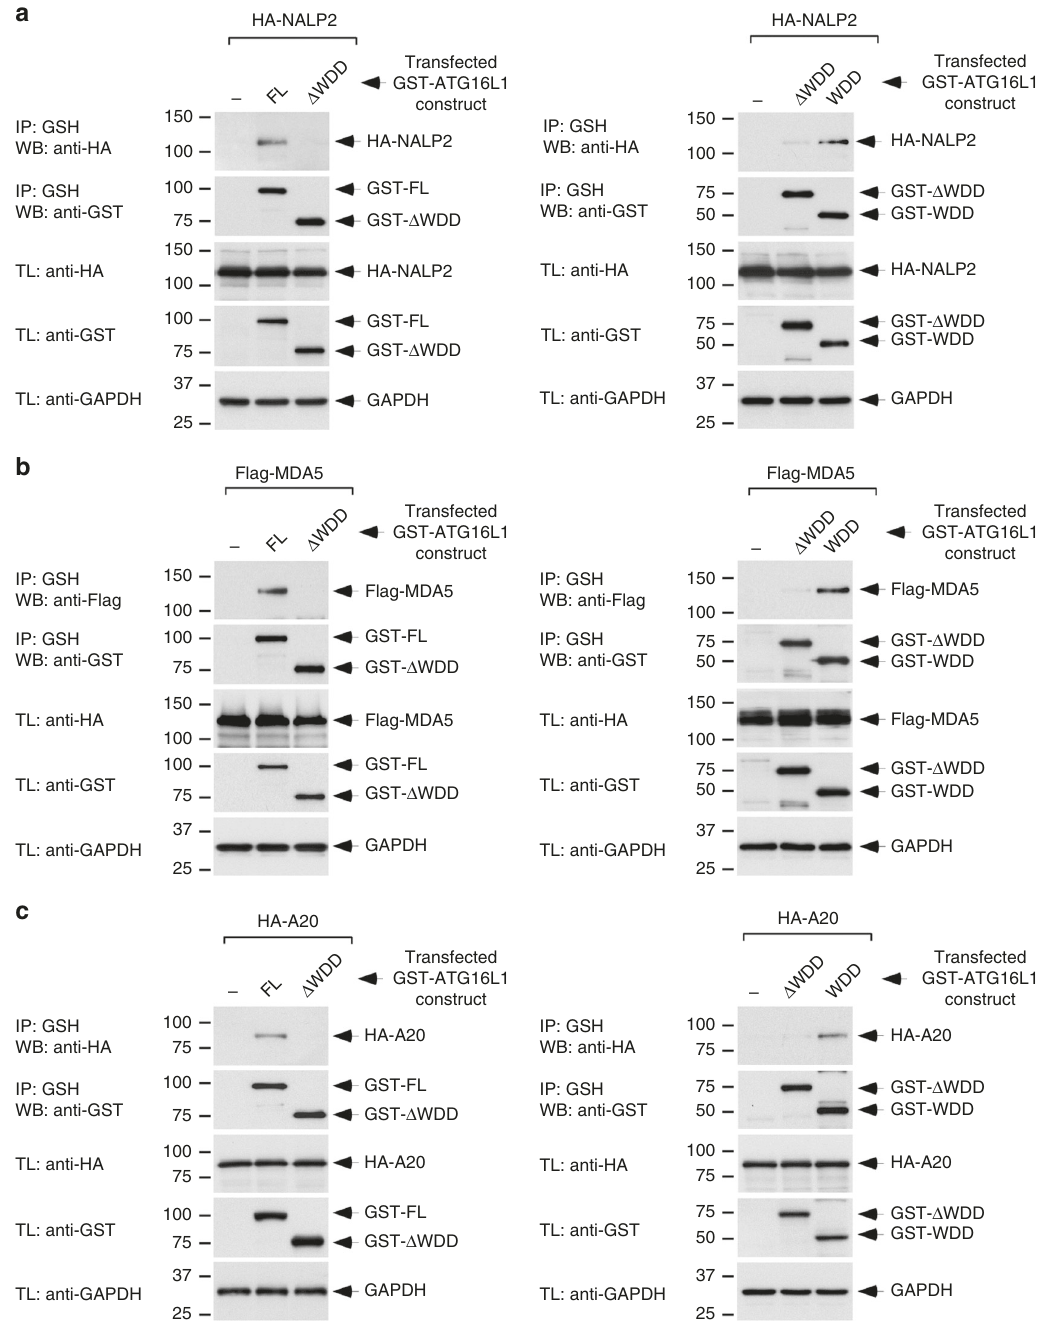
phosphorylation and sustained degradation of the NF- κ B inhi- bitory molecule I κ B α , consistent with the importance of A20 as a negative feedback regulator of inducible NF- κ B activation (Fig. 4a). In addition to the enhanced activation of the NF- κ B pathway, Atg16l1 expression levels are increased in A20-de fi cient cells, and more microtubule-associated protein 1 light chain 3 (LC3) protein associates with phosphatidylethanolamine (LC3-